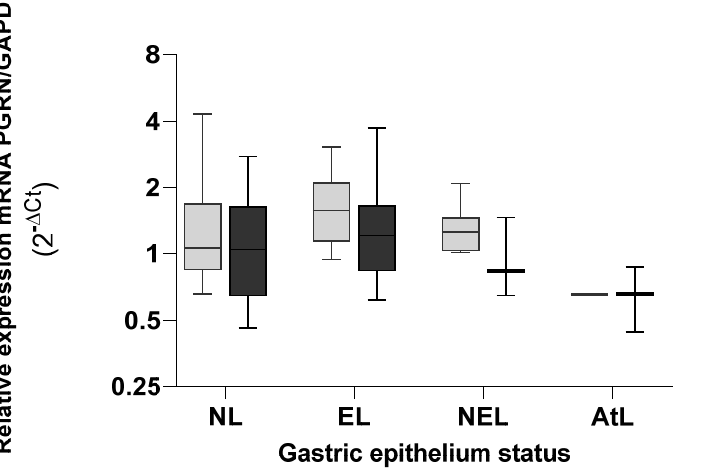
GRN fell in the presence and absence of cagA , the differences were not significant.